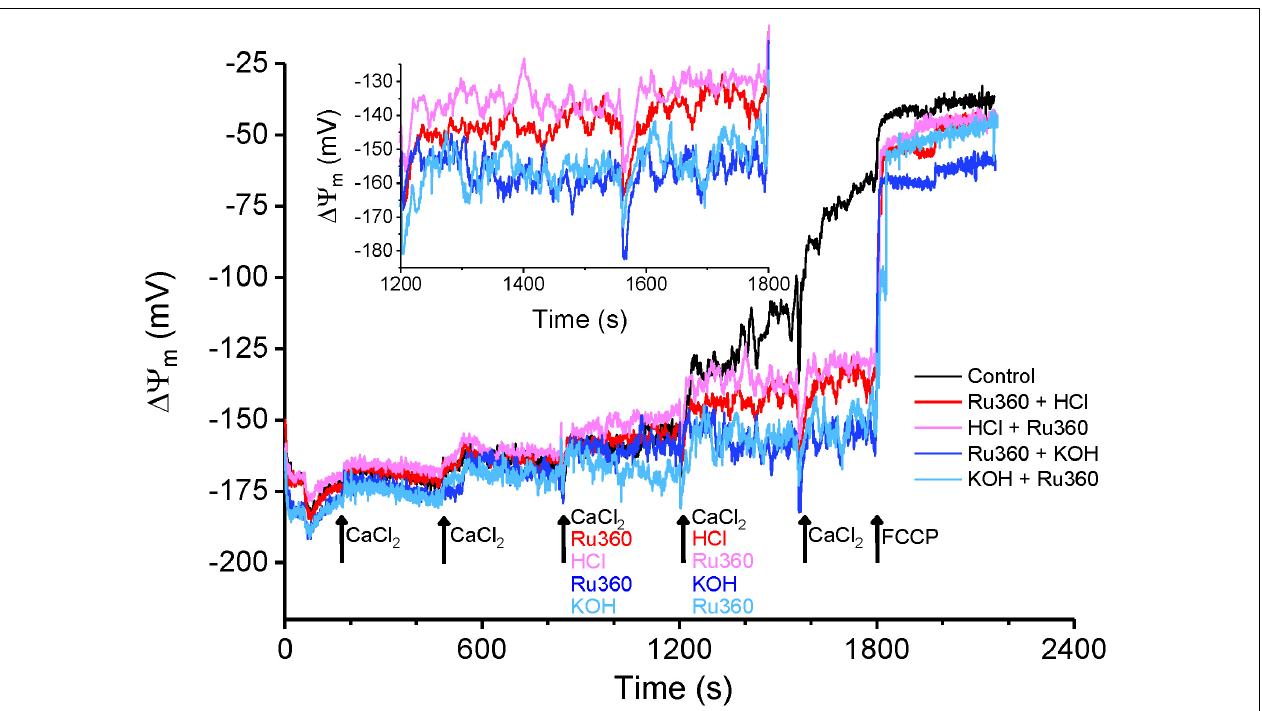
FIGURE 7 | Membrane potential changes in response to acidic and basic pH. Average (cid:49)(cid:57) m calculated as a function of TMRM intensity changes as described in section “Materials and Methods.” Membrane potential was evaluated for Control (black trace) and for interventions as indicated by arrows. For all traces, maximal depolarization was observed with the addition of 1 µ M FCCP at t = 1800 s. Inset: Enhanced detail of the graph between 1200 and 1800 s shows a depolarization caused by a change to more acidic pH in the buffer